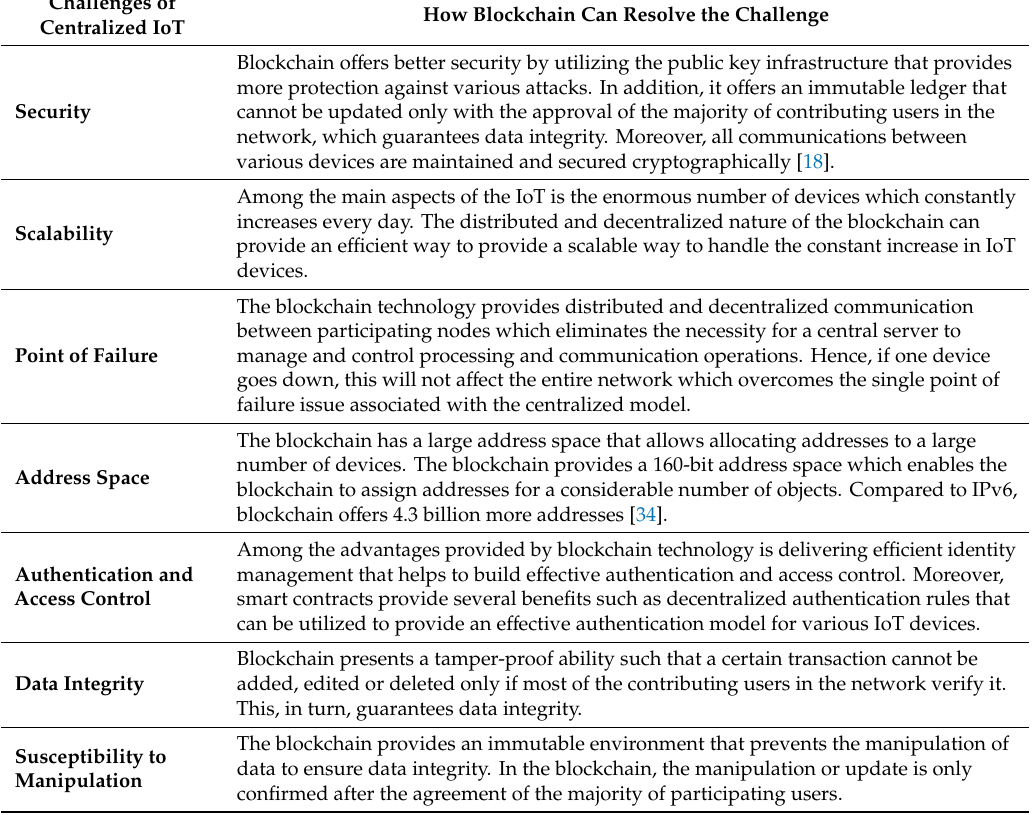
Table 3. Blockchain can provide innovative solutions to issues of the centralized IoT